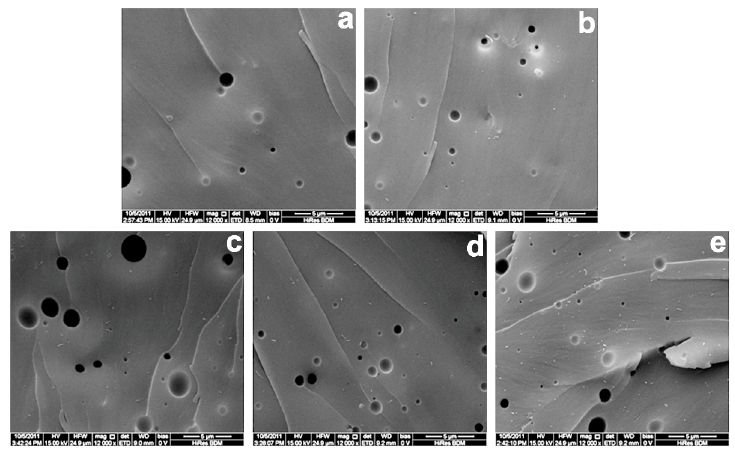
Figure 3. Scanning electron microscope (SEM) images of the nanocomposite bioplastics: ( a – e ) 0.0, 0.1, 0.5, 1.0, and 2.0 wt %, respectively.